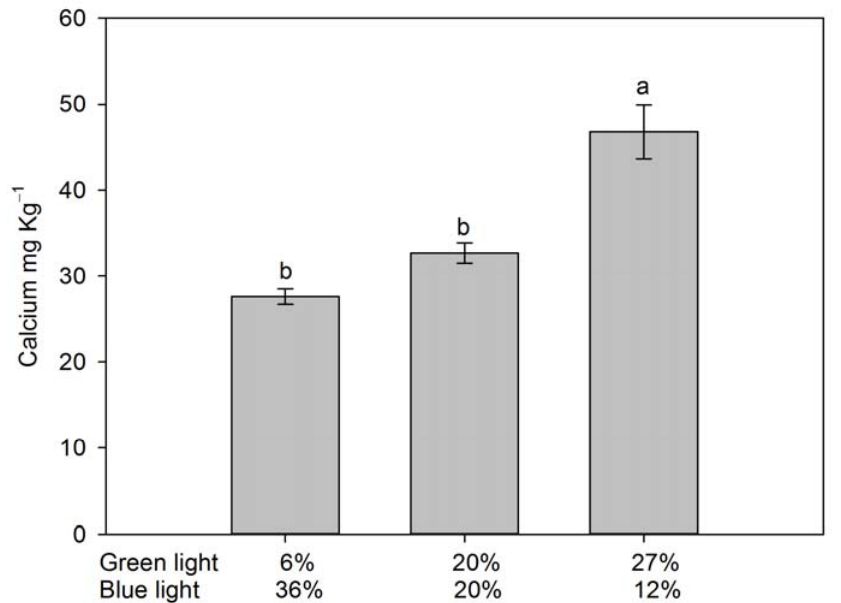
Figure 8. Effect of the green (500–600 nm) and blue (400–500 nm) light balance on calcium from fruit extracts of strawberry grown in an indoor vertical system with LED lighting. Bars represent the standard error of the mean. Columns with different letters indicate significant differences according to Duncan’s multiple comparison test with p < 0.05.